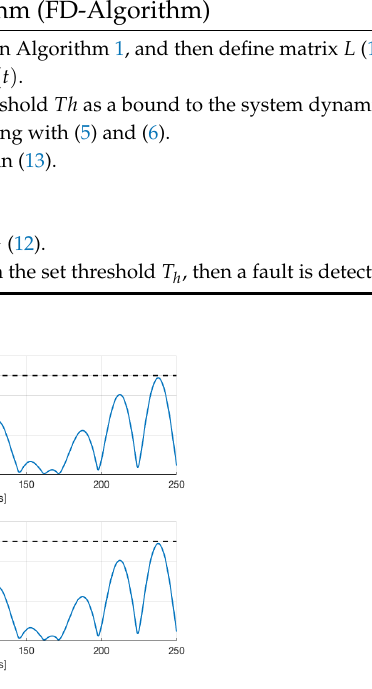
( t ) and e ( t ) for the nominal case H (see Algorithm 1). L 2 2